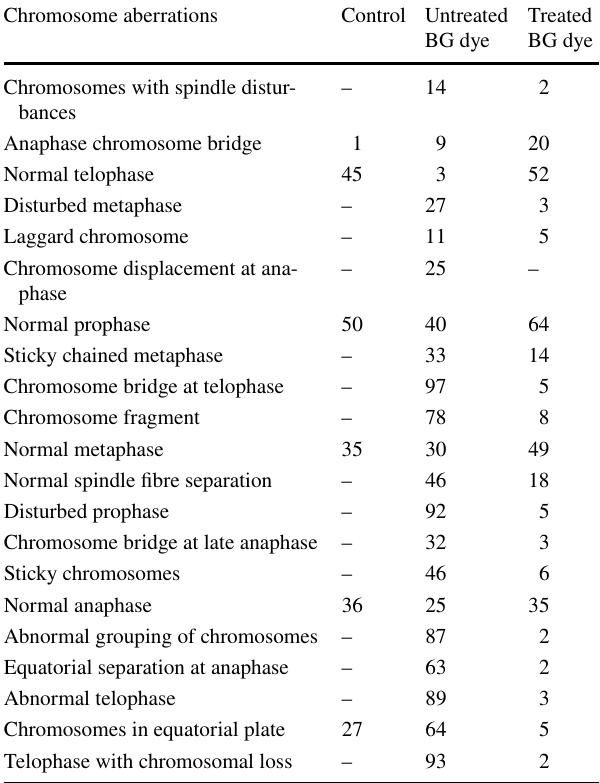
Table 5 Effect of untreated and S. wightii -treated BG dye on the induction of chromosomal aberration in Allium cepa Chromosome